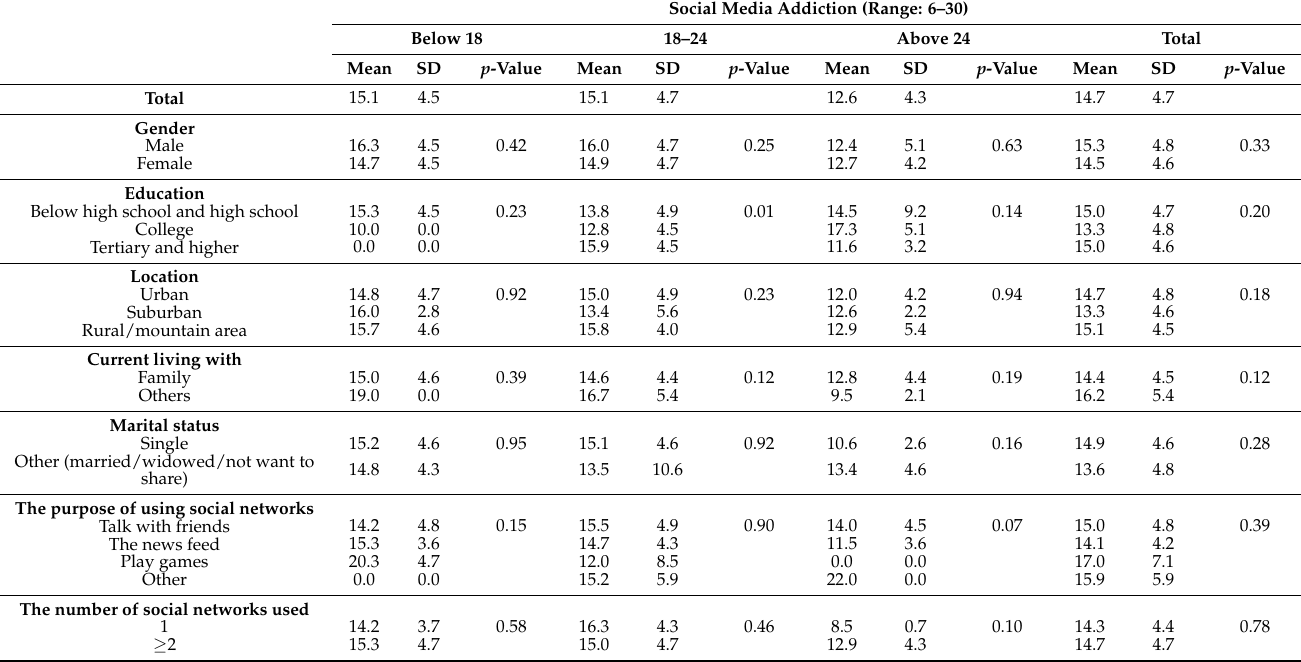
Table 2. Status of social media addiction among Vietnamese youths ( n = 173).